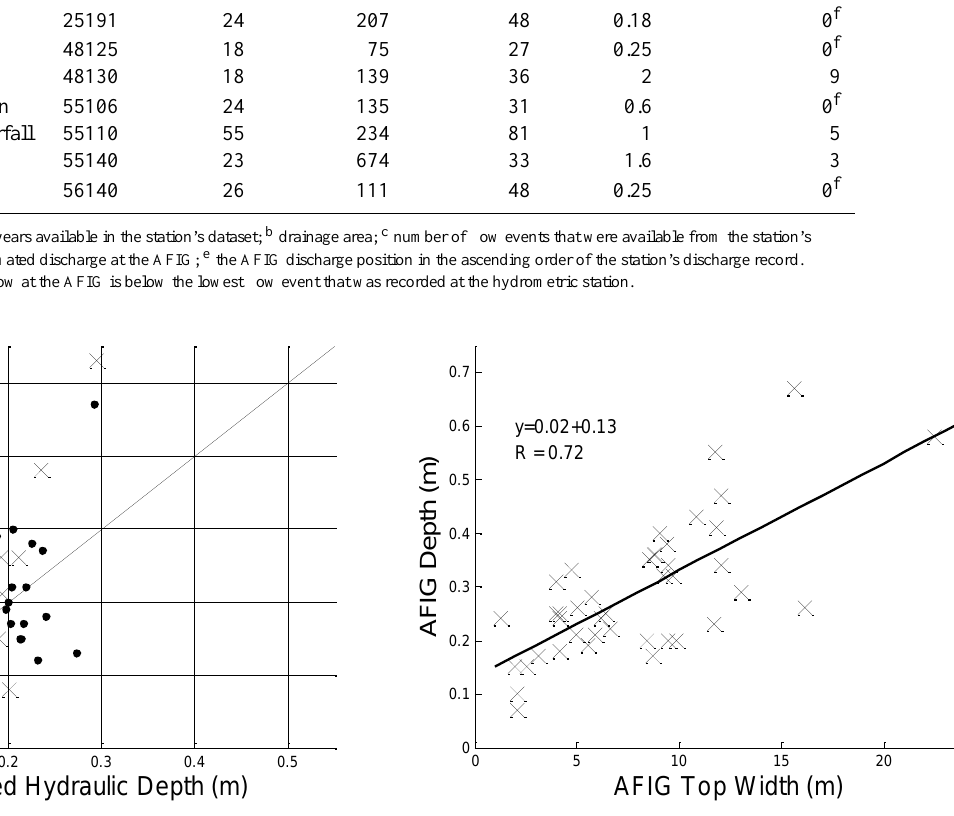
Figure 10. Surveyed relationships between top width and depth at the AFIG. Solid black line indicates a linear regression fit.